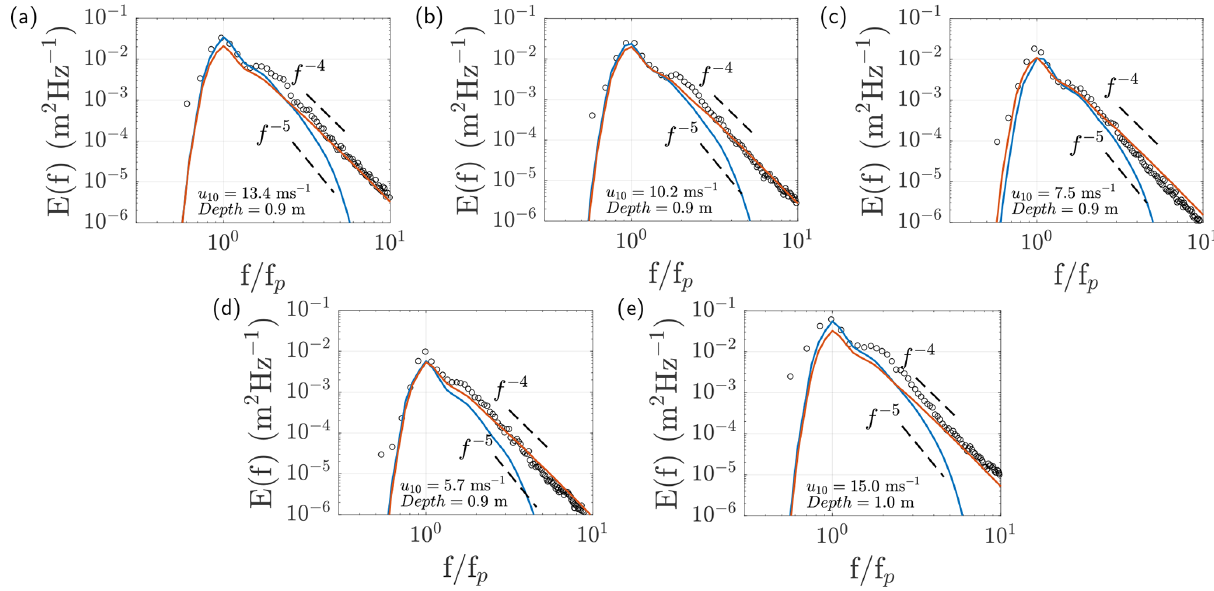
Figure 5. One-dimensional wave spectrum measured by (Young and Babanin, 2006b) (black circles) for fully developed waves in shallow water and the results from SWAN with KOM (blue lines) and WBLM (red lines) source functions after 24h simulation. Table 5. Statistics of simulated significant wave height ( H m 0 ), mean wave direction ( D mean ), and peak ( T p ) and mean ( T m 01 ) wave period in comparison to buoy measurements at the RUNE site on 28 November 2015 and 12 August 2015. The statistics include mean difference (bias), root mean square error (RMSE), and scatter index (SI). In each column, the values of smallest absolute errors are indicated with bold text.